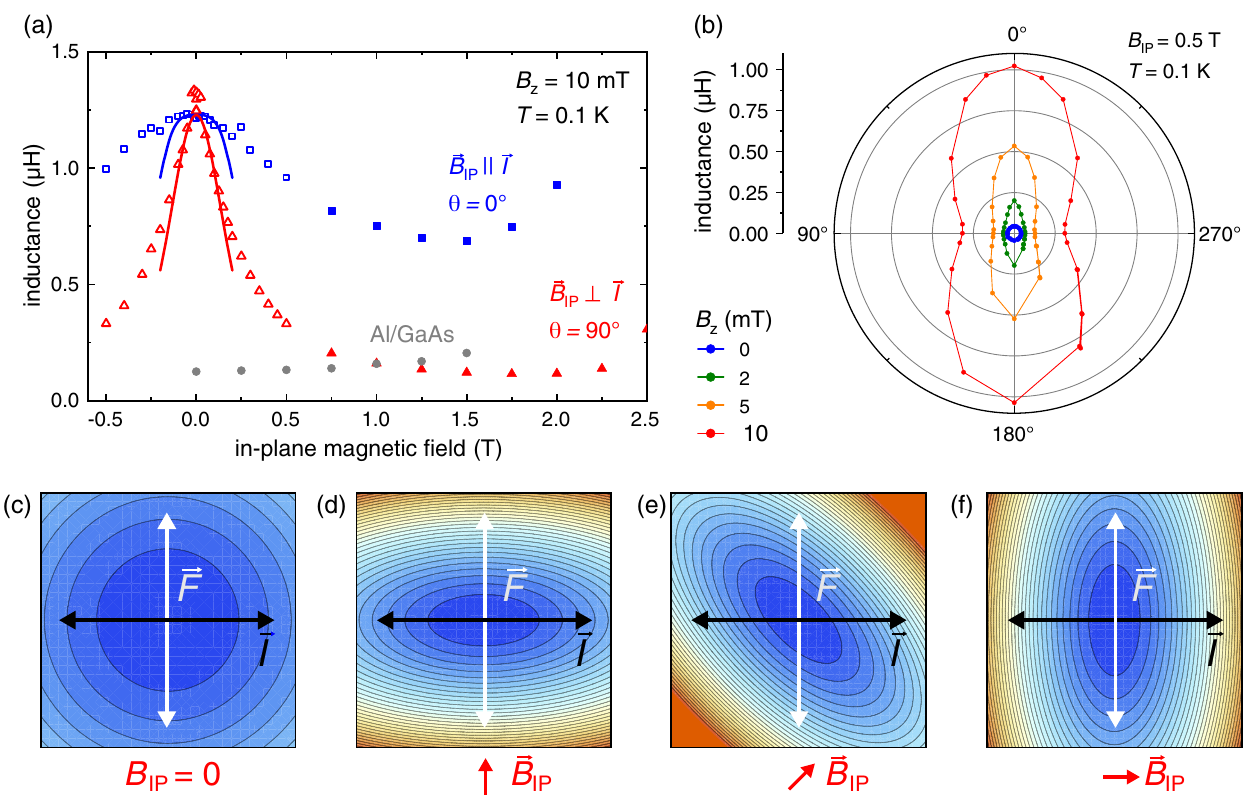
FIG. 2. Anisotropic vortex squeezing under in-plane field. (a) Sample inductance measured at T ¼ 0 . 1 K as a function of B for IP B k ˆ x ( θ ¼ 0 °, blue symbols) and for B k ˆ y ( θ ¼ 90 °, red symbols). The out-of-plane field B ¼ 10 mT corresponds to the linear z IP IP regime in Fig. 1(c). Empty and full symbols refer to two measurement sessions with higher resolution at low fields and lower resolution at high fields, respectively. We also report the results (gray symbols) of the control measurement performed on a sample with epitaxially ⊥ I ( B k I ) to the analytical grown Al on intrinsic GaAs. The solid red (blue) curve is obtained by fitting the experimental data for B IP IP model; see text. (b) Polar plot showing the angle θ dependence of the vortex inductance for selected values of B . (c) The color plot z schematically represents the modulus of the order parameter j Ψ ð x; y Þj 2 near the core of a pinned vortex, in the absence of in-plane field B . The horizontal black arrow represents the direction of an oscillating current bias I k ˆ x , which exerts a Lorentz force F k ˆ y , white IP arrow. The measured vortex inductance is rotation symmetric and inversely proportional to the curvature of j Ψ ð x; y Þj 2 along F . (d) When a finite in-plane field is applied along ˆ y , the vortex core is squeezed as a consequence of the Rashba spin-orbit interaction. In this plot the curvature k ( k ) along the x axis ( y axis) is 1.64 (7.66) times that shown in (c), reflecting the measured change in vortex inductance for x y ¼ 1 T; see text. The curvature is always probed along F k ˆ y . (e),(f) By rotating B B clockwise, the anisotropic vortex core rotates IP IP accordingly. Since the F direction stays constant, such rotation makes it possible to probe the curvature of j Ψ ð x; y Þj 2 along an arbitrary direction and thus to extract its spatial tomography. The color range and level spacing is arbitrary, but the same in all the color